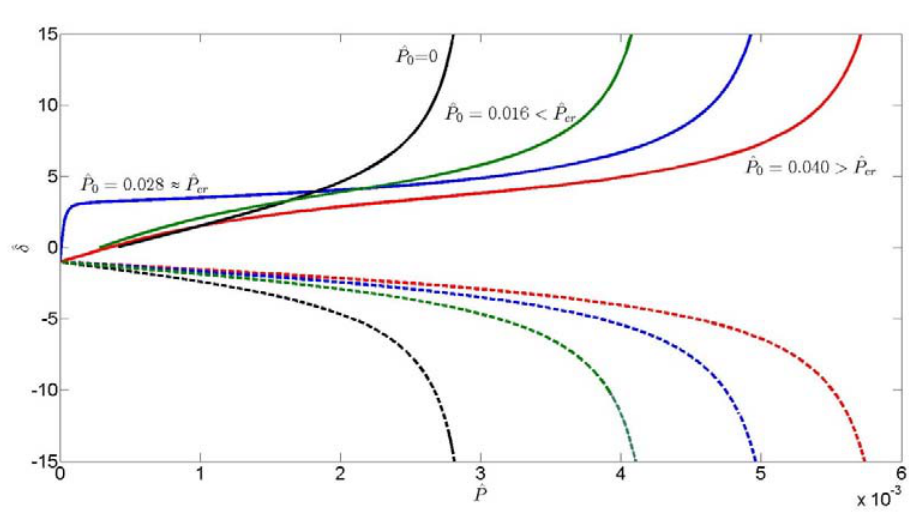
 for different values of the eq